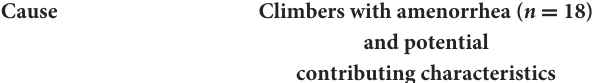
TABLE 5 Plausible causes of